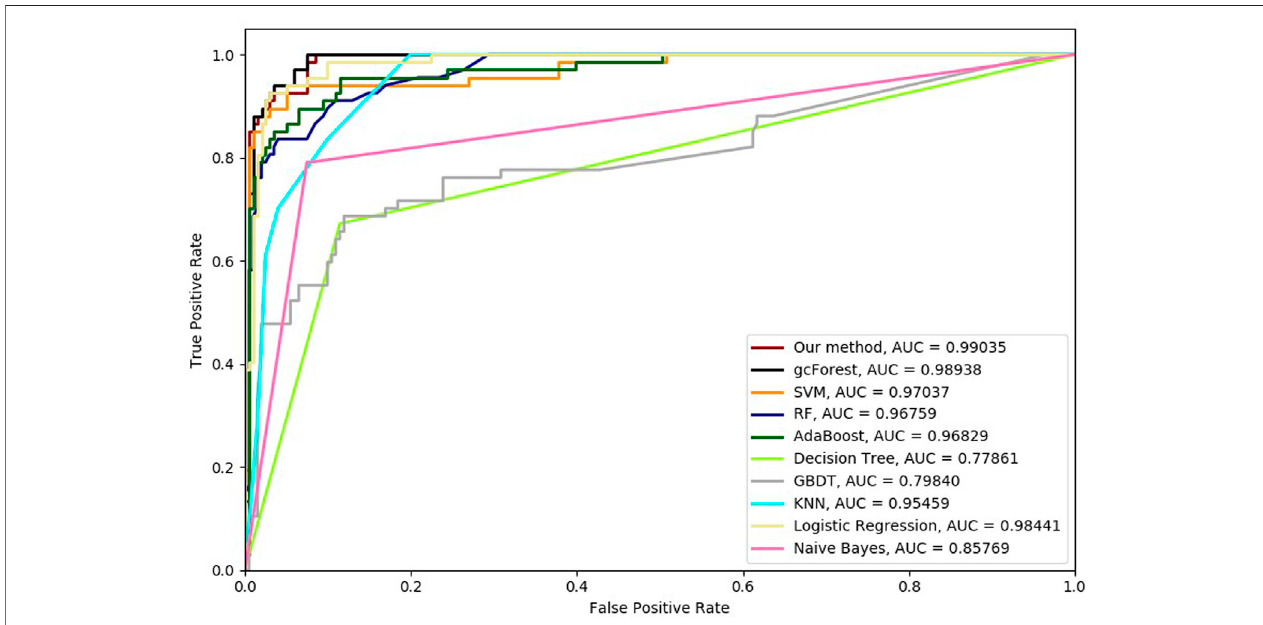
FIGURE 4 | Hypertension-related compound identi fi cation performances of ten methods with 2-cross validation methods.